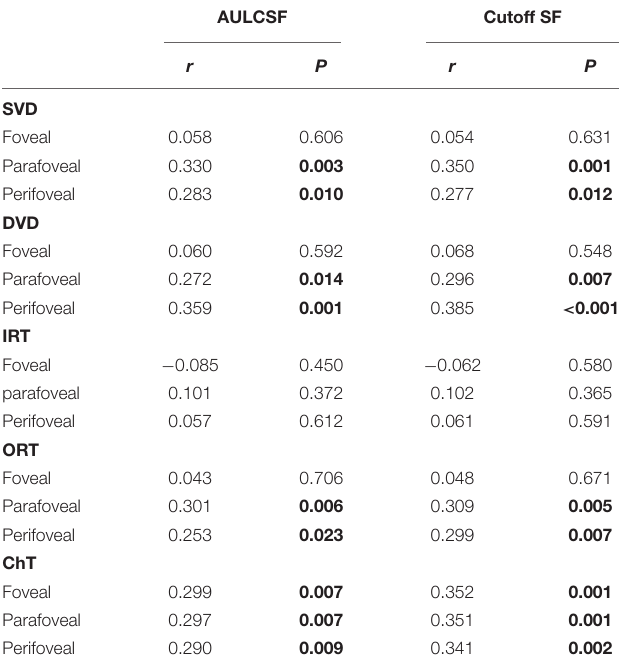
TABLE 4 | Correlation between the contrast sensitivity function and the chorioretinal structure and vasculature in myopia. AULCSF Cutoff SF